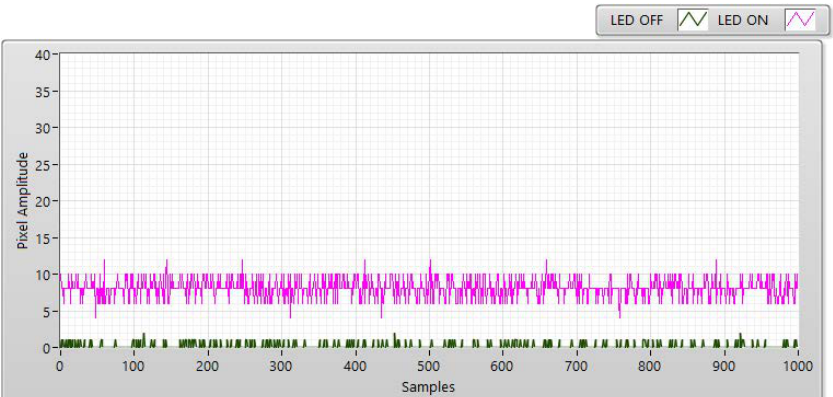
Figure 8. SNR measurement with a Point Grey rolling shutter camera at a communication distance of 15 m with 100 µs.